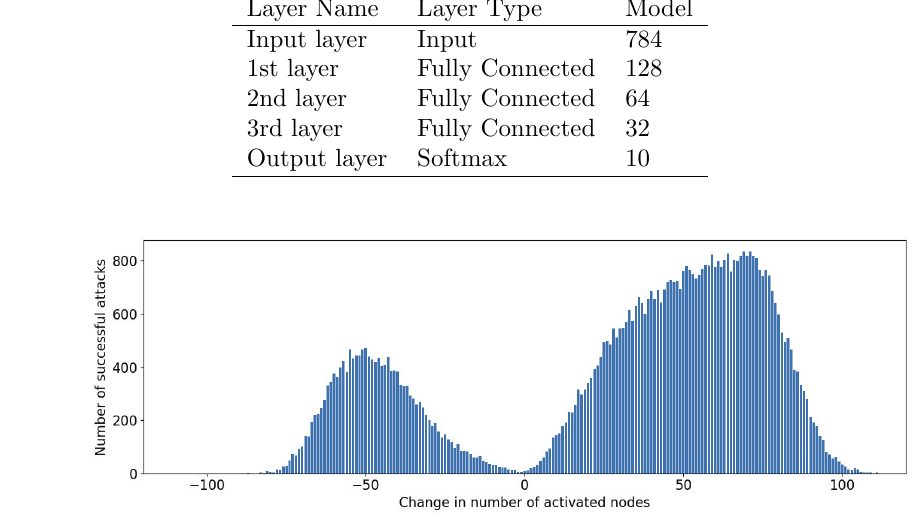
Figure 5: Simulation of relationship between the change in the number of all layers’ activated nodes and the number of successful attacks (misclassification) in the MLP model with ReLU.